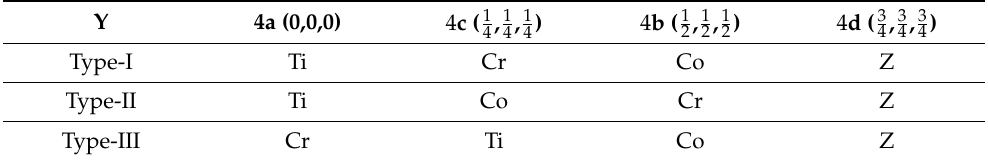
Figure 1. Primitive unit cells of CrTiCoAl quaternary Heusler alloys in the Y-Type-I,. Y-Type-II and Y-Type-III configurations. Table 1. Wyckoff positions of the atoms in different configurations (Z stands for Al or